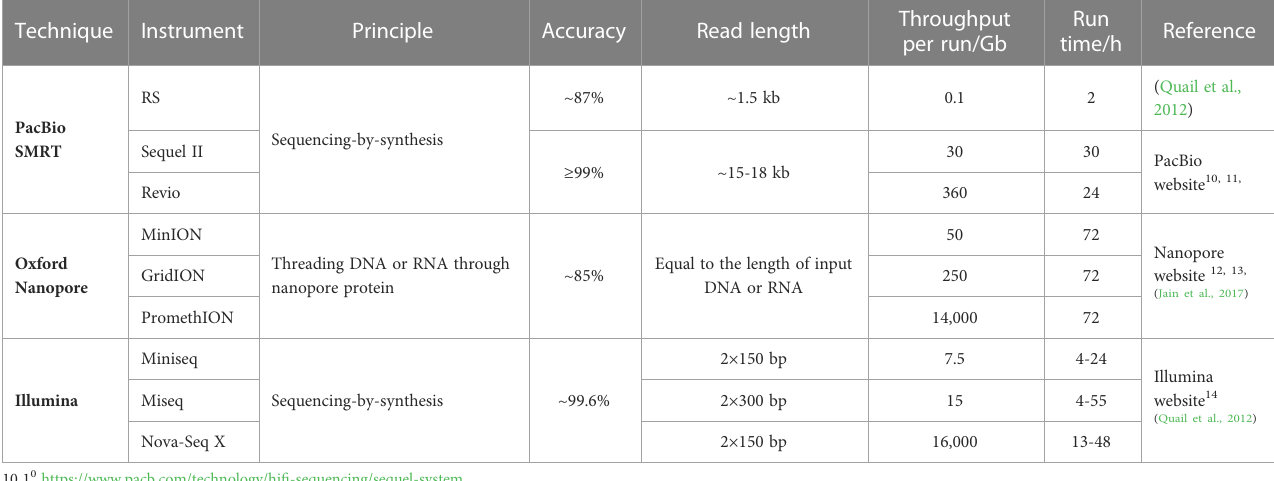
TABLE 1 Comparison of SMRT, ONT and Illumina representative instruments.